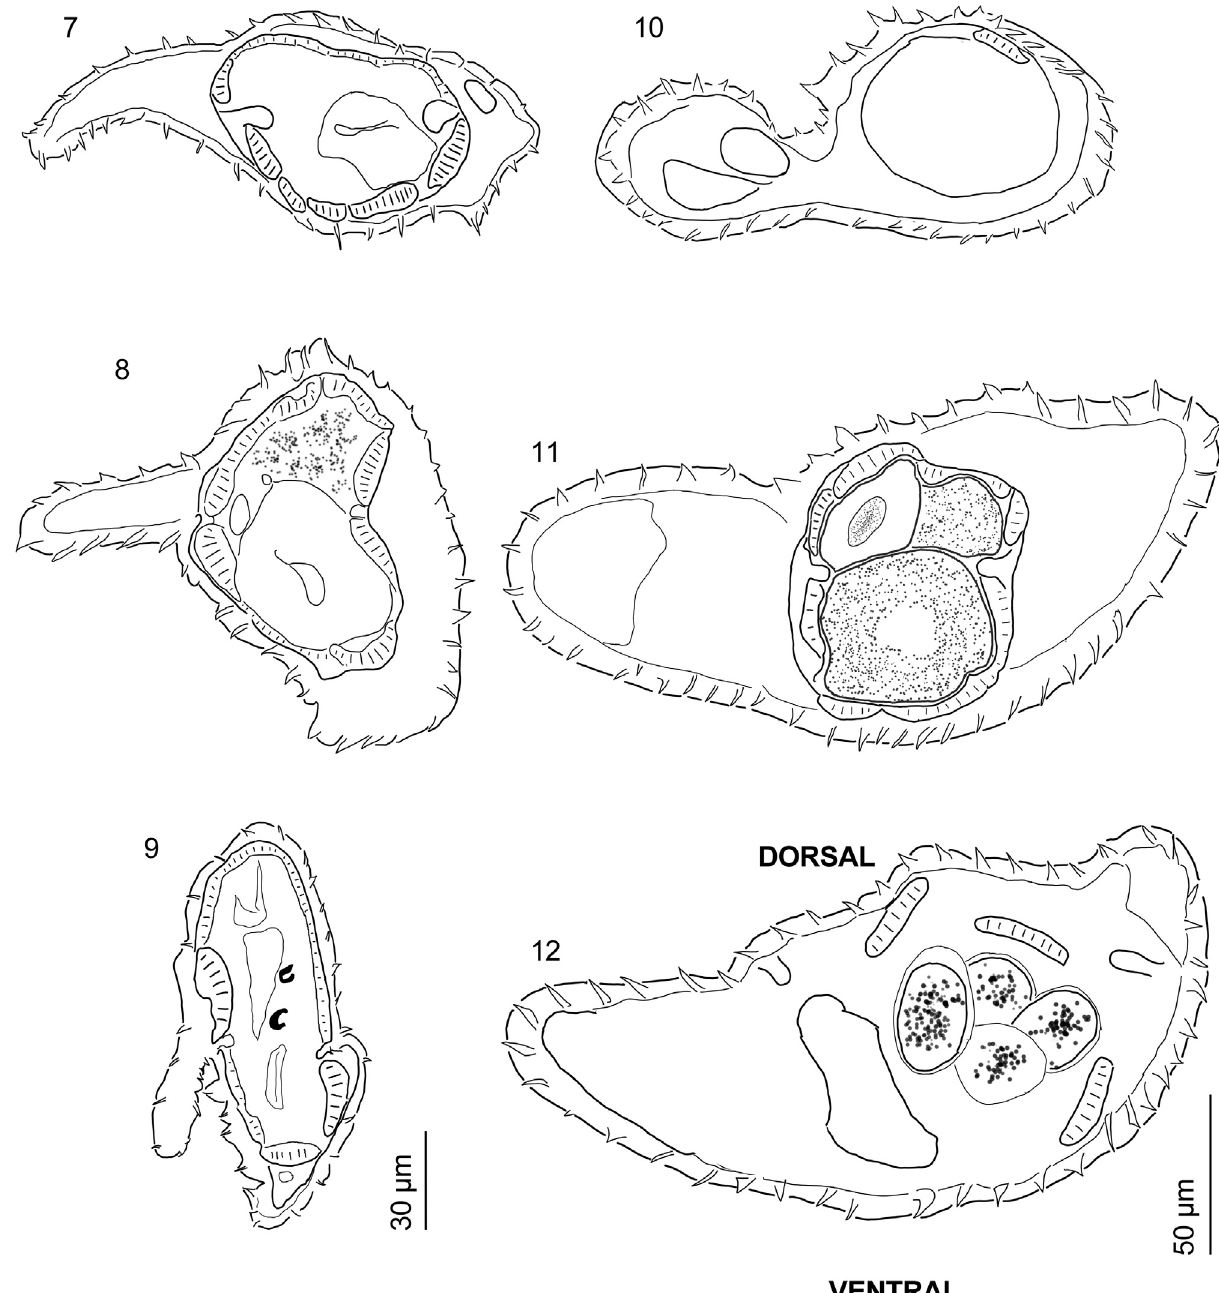
Figures 7–12. Guerrerostrongylus marginalis n. sp., orientation of all sections is dorsal side toward the top of page, ventral side toward the bottom of page. 7–9 , Synlophe of male paratype, scale bar 30 l m. 7, At level of esophagus. 8, At midbody. 9, At posterior end, showing spicules. 9–11 Synlophe of female paratype, scale bar = 50 l m. 10, At level of esophagus. 11, At midbody. 12, At proximal portion of